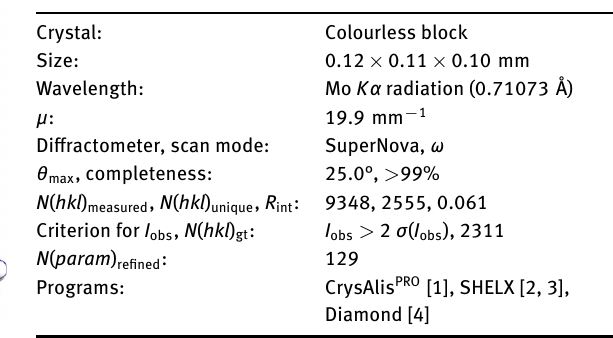
Figure 1: Showing the organic cation and a part of the polymeric PbCl 3 − coordination polymer.